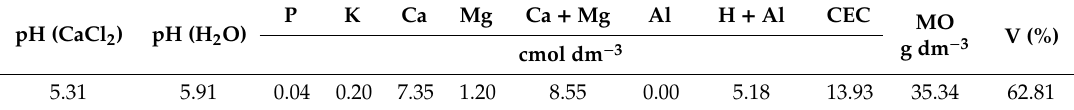
Figure 1. Localization of Fazenda Escola (study area) and experimental plots. Table 1. Chemical characteristics of soil samples from the experimental area.